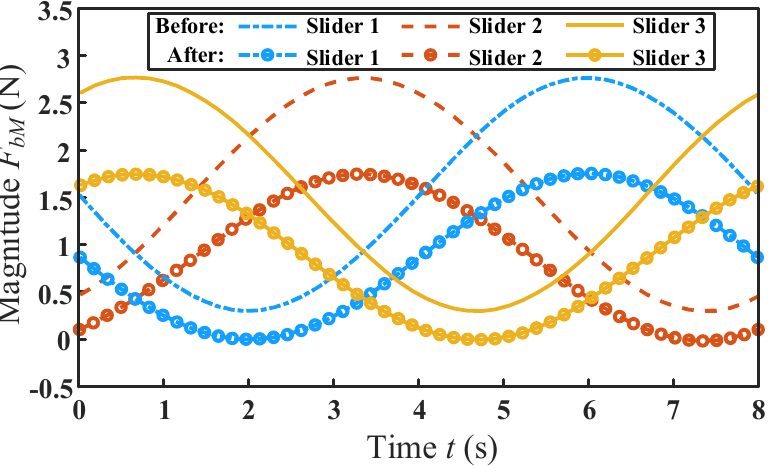
Figure 12. The comparison of driving forces before and after optimization. The structural parameters of the flexure spherical hinge and the dynamic performance of the mechanism before and after optimization are shown in Table 4. It can be seen from the comparison that the overall mass of the mechanism is reduced by 8.34% after optimization, which greatly reduces the inertial force of the mechanism. At the same time, it is also found that the stiffness and first-order natural frequency of the mechanism are reduced to a certain extent, but they are all within the allowable range. In addition, the ultimate angular displacement of the optimized flexure spherical hinge is slightly reduced, but it is still much larger than the initial set value of 1 ◦ . In conclusion, optimization based on dynamic performance is feasible and effective. It can be seen that when the acceleration in Equation (9) is 0, the dynamic equation is transformed into a static equation. Thus, the optimization method is also suitable for optimization design based on a quasi-static